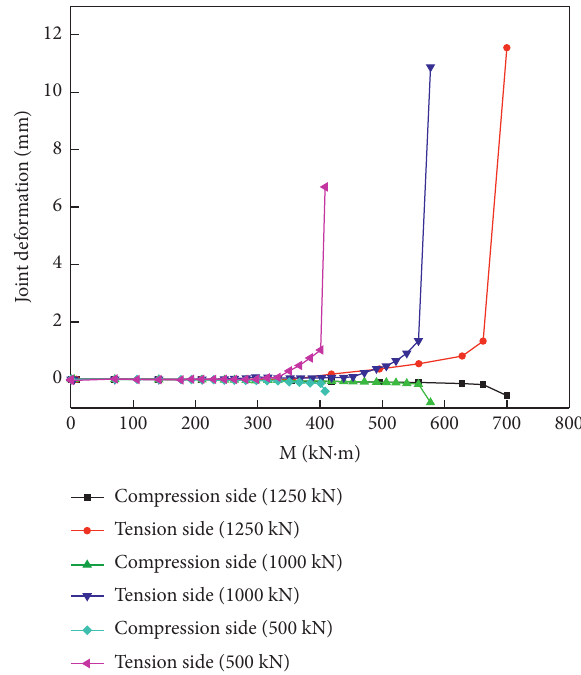
Figure 11: Deformation development of double-tenon joints without auxiliary pretightening